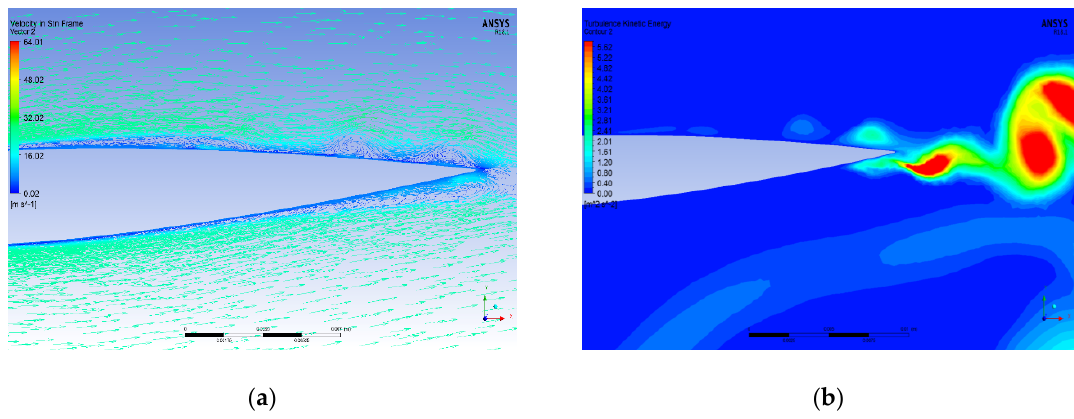
Figure 14. Velocity vectors ( a ) and contours of turbulence kinetic energy ( b ) for a blade at θ = 0° and λ max = 0.29.